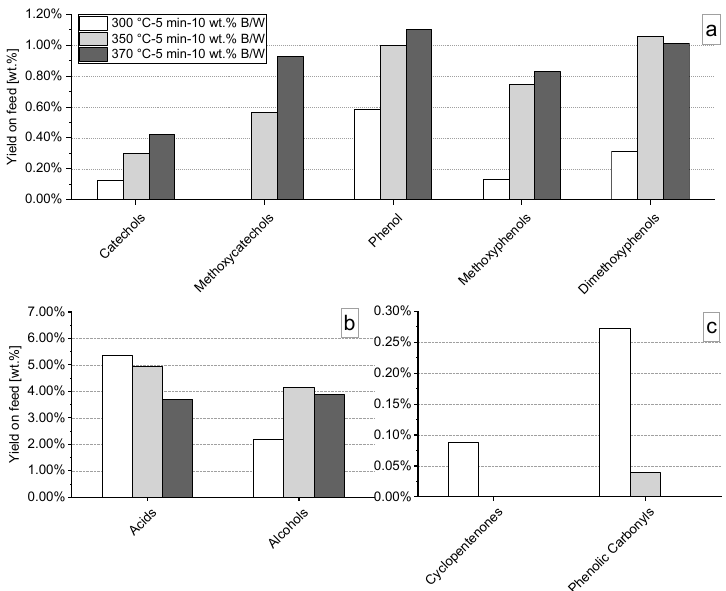
Figure 5. Effect of reaction temperature on yields of quantified compounds for uncatalyzed HTL tests: ( a ) phenolics, ( b ) acids and alcohols, ( c ) phenolic carbonyls and cyclopentenones. When no graph column is depicted, the concentration was below quantification limits.